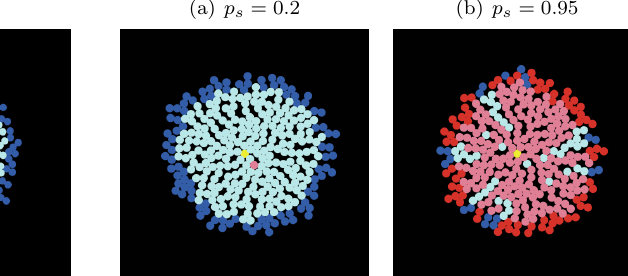
Figure 1: Two realizations of the simulation for p s = 0 . 5 after 15 days. (a) There are no CSCs at the periphery; all of them, colored in pink, became quiescent. (b) The active CSCs at the border are colored in red. Note that some branches failed to percolate. DCCs are depicted in cyan (quiescent) and blue (active). The seed is rep- resented in yellow.